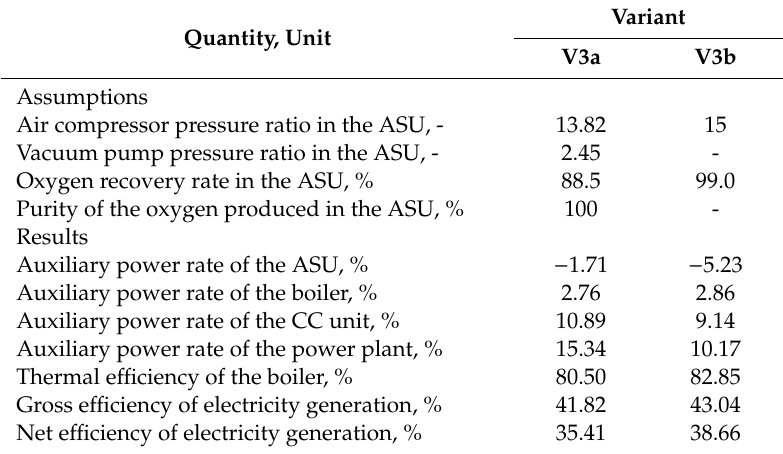
Table 7. Thermodynamic analysis results (variants V3a and V3b).